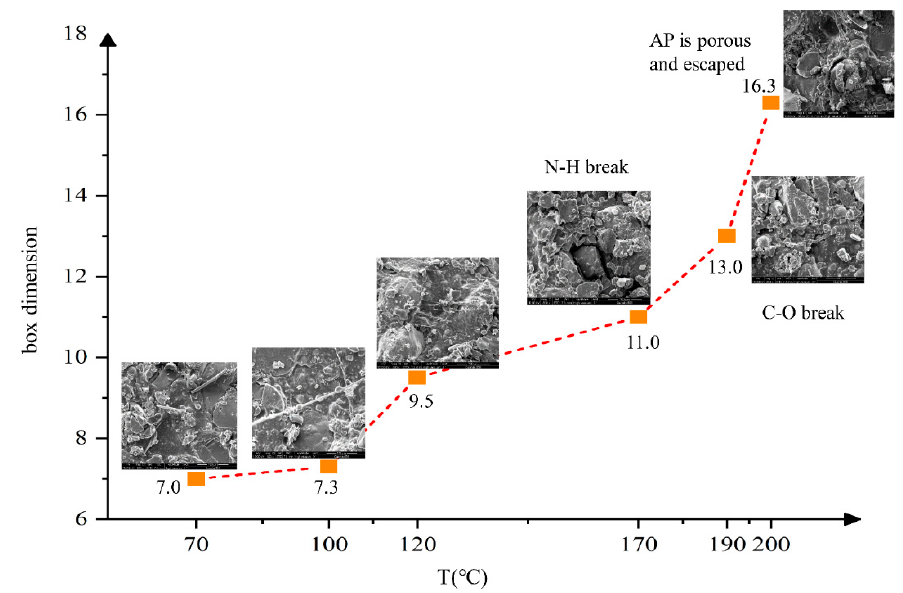
Figure 14. Defect figure of HTPB propellant at different temperatures during slow cook-off.